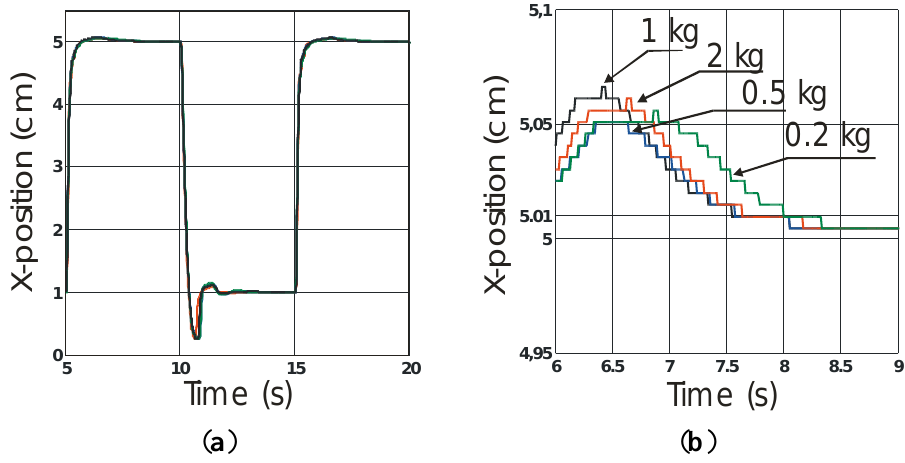
Figure 8. Step responses performed by our metal McKibben muscle driving various loads ( a ) and ( b ) Close-up of the convergence towards the final desired position.